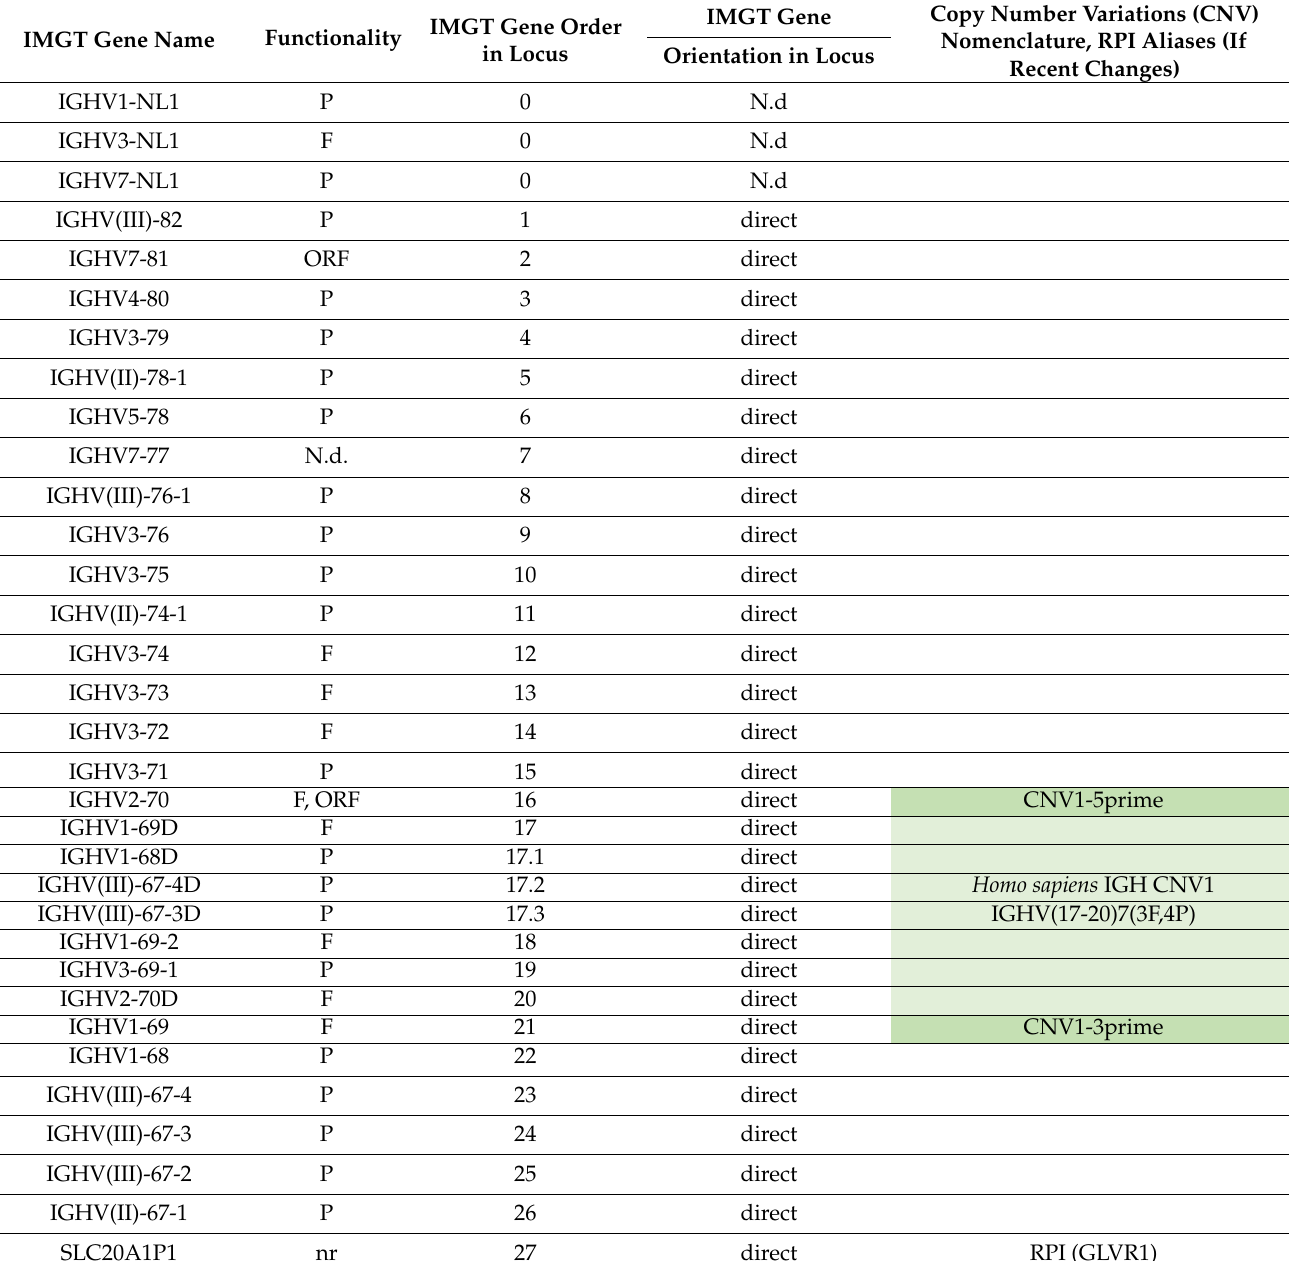
Table 3. Homo sapiens IGH locus: IMGT gene order and copy number variations